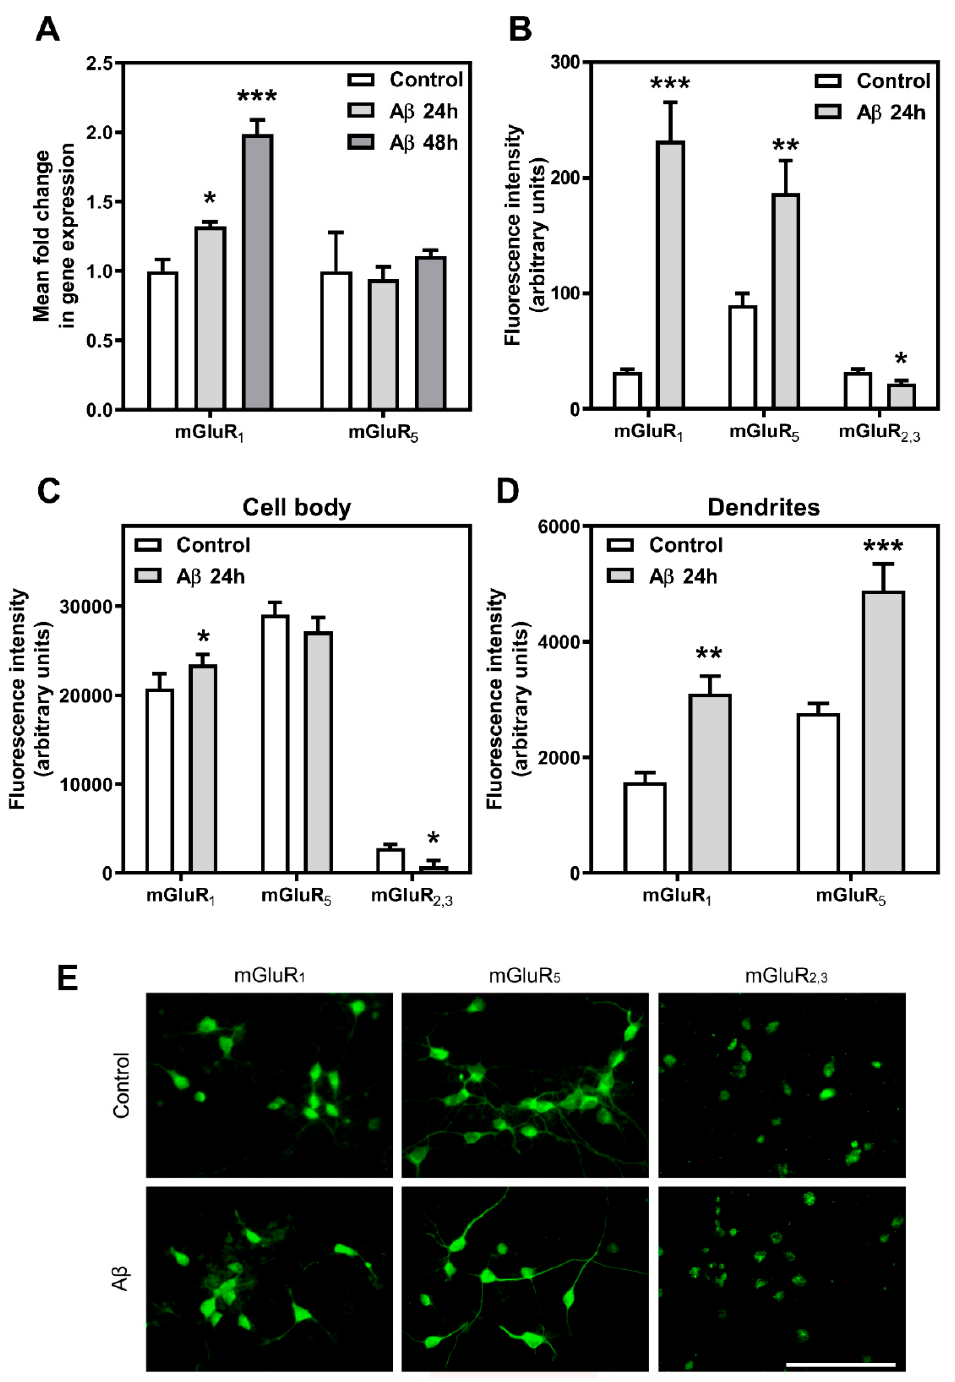
Figure 2. A β 25-35 effect on mGluR gene expression and protein level. ( A ) Quantitative real time PCR assays after A β 25-35 treatment were performed as described in Methods. Histograms represent mean ± SEM values obtained from, at least, three independent experiments performed in duplicate using different preparations. ** p < 0.01, *** p < 0.001 significantly different from control value using one-way ANOVA and Bonferroni’s post hoc test. The effect of A β 25-35 treatment on mGluR 1 , mGluR 5 , and mGluR 2,3 membrane protein level was assayed using image analysis of immunostaining in the whole-cell ( B ), the cell bodies ( C ), and the dendrites ( D ). Histograms represent mean ± SEM values obtained from, at least, three independent experiments performed in duplicate using different preparations. * p < 0.05, ** p < 0.01, *** p < 0.001 significantly different from untreated condition using two-tailed Student’s t -test. ( E ) Representative photomicrographs of mGluR 1 , mGluR 5 , and mGluR 2,3 immunochemistry in control and A β 25-35- treated cortical neurons. Bar represents 100 µm.